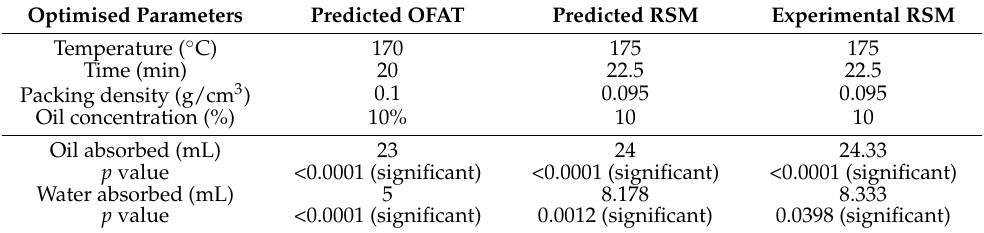
Table 7. Validation model using the predicted optimum value in OFAT and